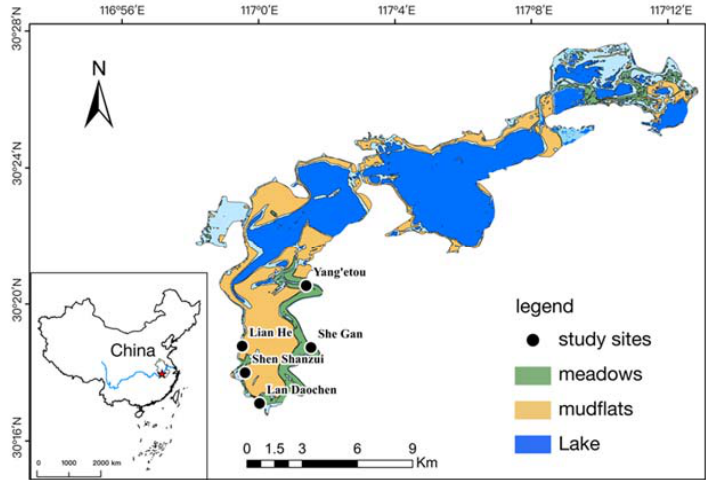
Figure 1. The study sites in the upper part of Shengjin Lake, China.